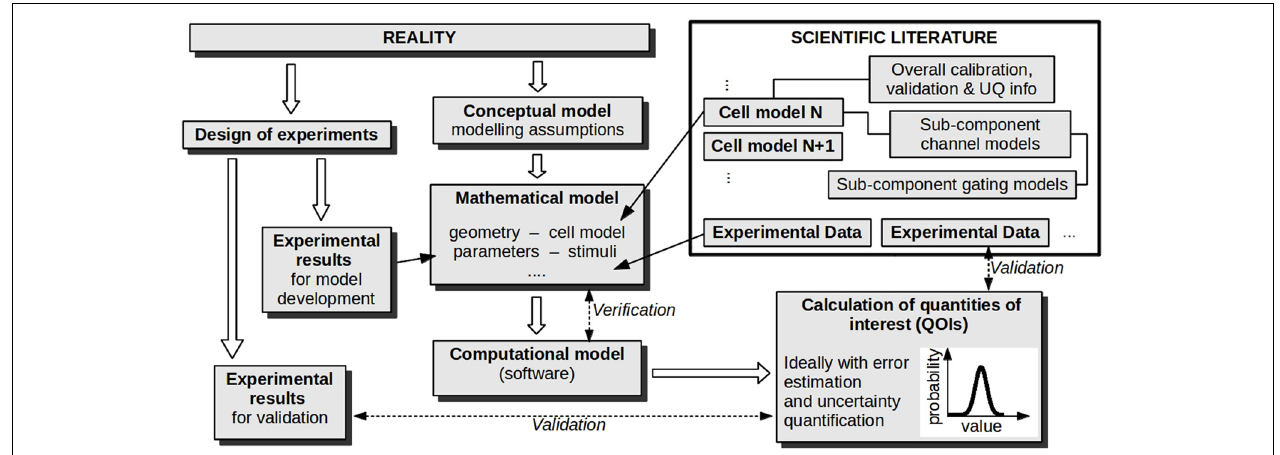
FIGURE 2 | Stages in developing and evaluating a model for a particular cardiac application . Verification and validation activities are labeled with dashed arrows. If uncertainty quantification is performed, parameter values are represented as probability distributions (not shown), and this uncertainty